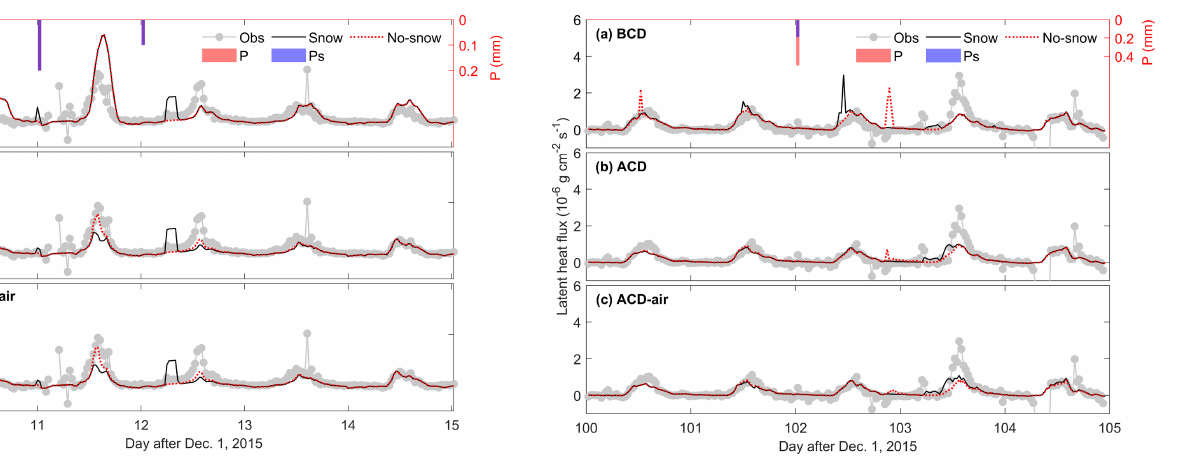
Figure 7. Observed and model simulated latent heat flux using (a) BCD, (b) ACD, and (c) ACD-air soil models with and without the snow module of a typical 5d thawing period (from the 100th to 104th day after 1 December 2015). P is the precipitation and Ps is the